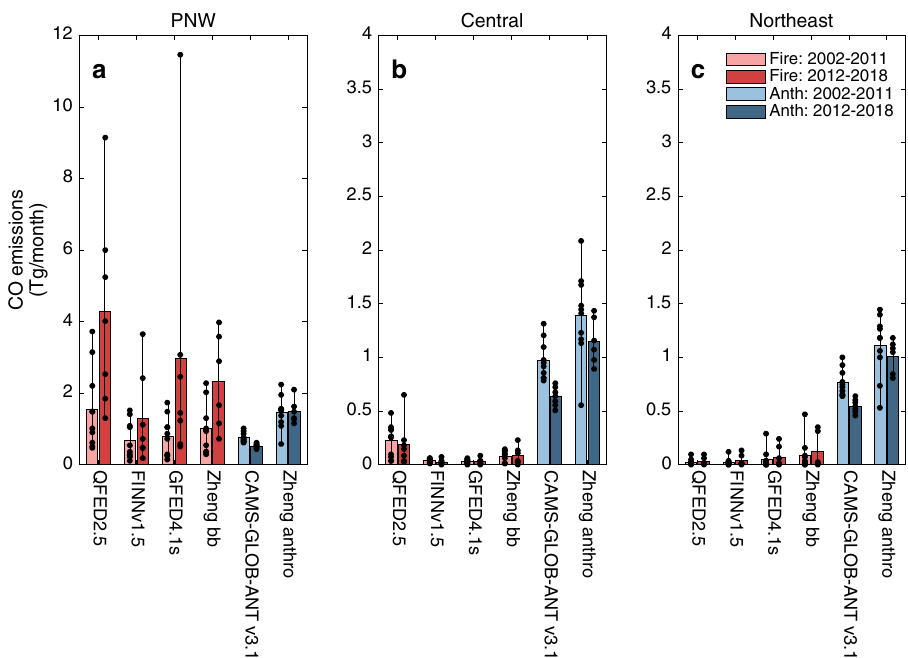
Fig. 5 Regional comparison of August carbon monoxide (CO) emissions. Mean August CO emissions are shown in terragrams (Tg) for the two time periods (2002 – 2011, light colors, and 2012 – 2018, dark colors) for the three study regions: a PNW, b Central USA and c Northeast. We assess wild fi re emissions from four inventories (Fire, red): QFED2.5, FINN1.5, GFED4.1s, and Zheng reanalysis, and two anthropogenic inventories (Anth, blue): CAMS- GLOB-ANT v3.1 and Zheng reanalysis. Note, Zheng reanalysis ends in 2017. Black circles represent regional August means for each year within the time